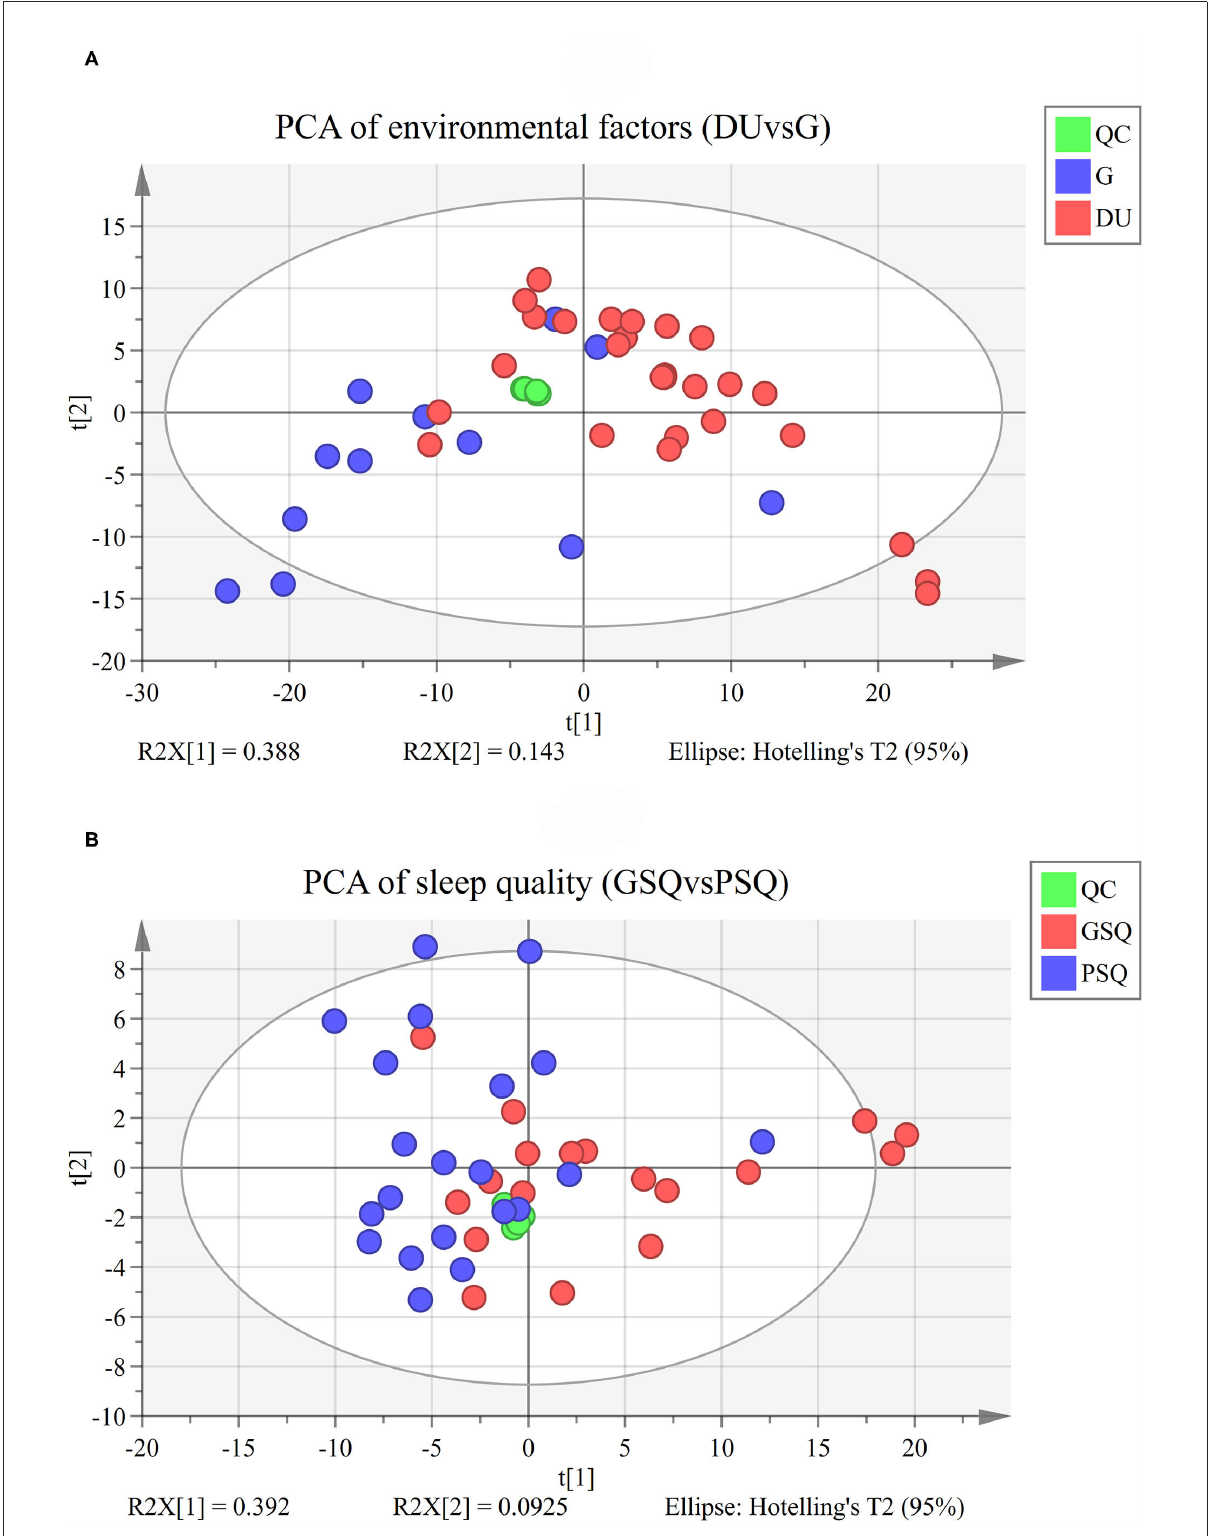
FIGURE1 (A) PCA of the environmental factor group (DUvsG), DUvsG refers to the group “Deep-underground vs. ground,” and QC refers to the “quality control” samples. PCA refers to the principal component analysis; (B) PCA of the sleep quality group (GSQvsPSQ), GSQvsPSQ refers to the group “Good sleep quality vs. poor sleep quality,” and QC refers to the “quality control” samples. PCA refers to the principal component